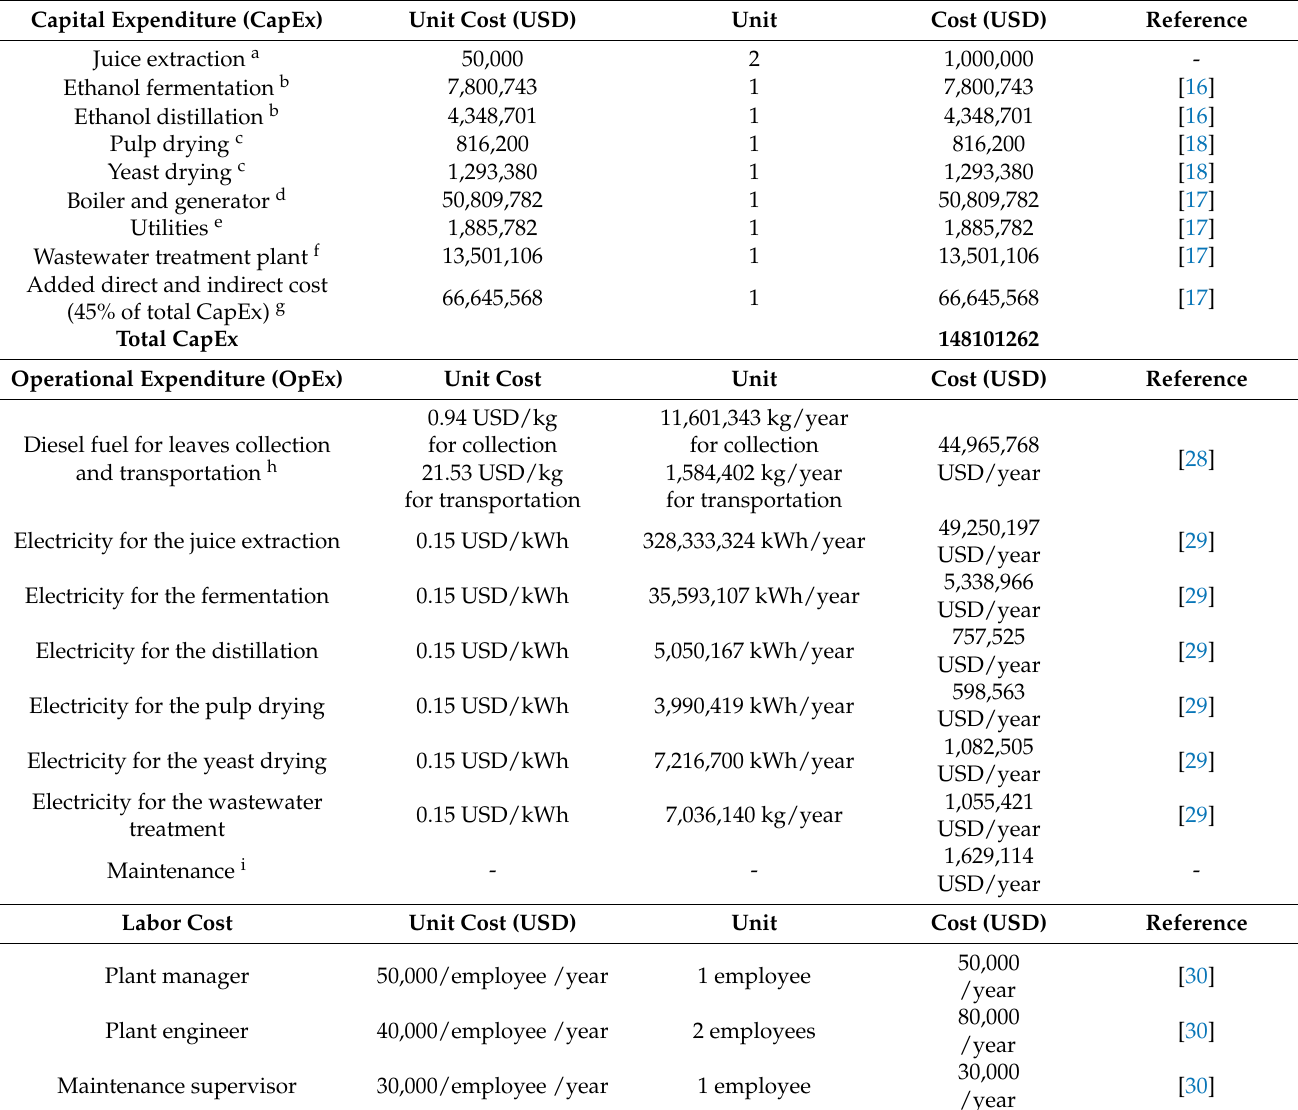
Table 4. Economic performance of a biorefinery with a capacity of 50,000 metric tons ethanol per year from pineapple leaves in Costa